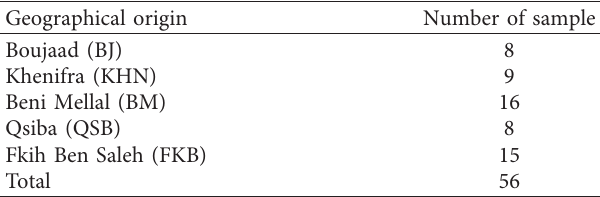
Table 1: Geographical origin of the collected olive oils. Geographical origin Number of